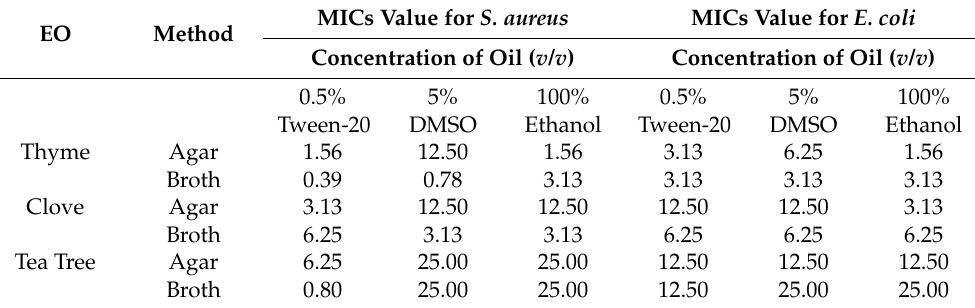
The minimal inhibitory concentration (MIC) (%) of essential oils in three different solvents ( v / v